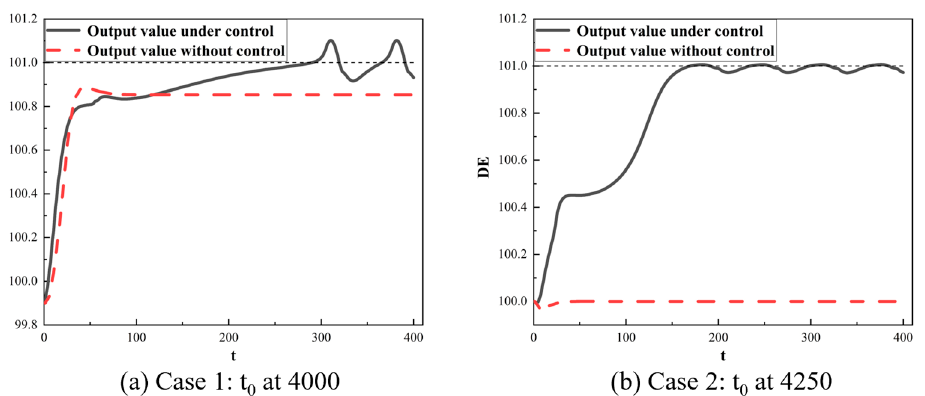
Figure 9. The state profiles for different time of case 1 and case 2.